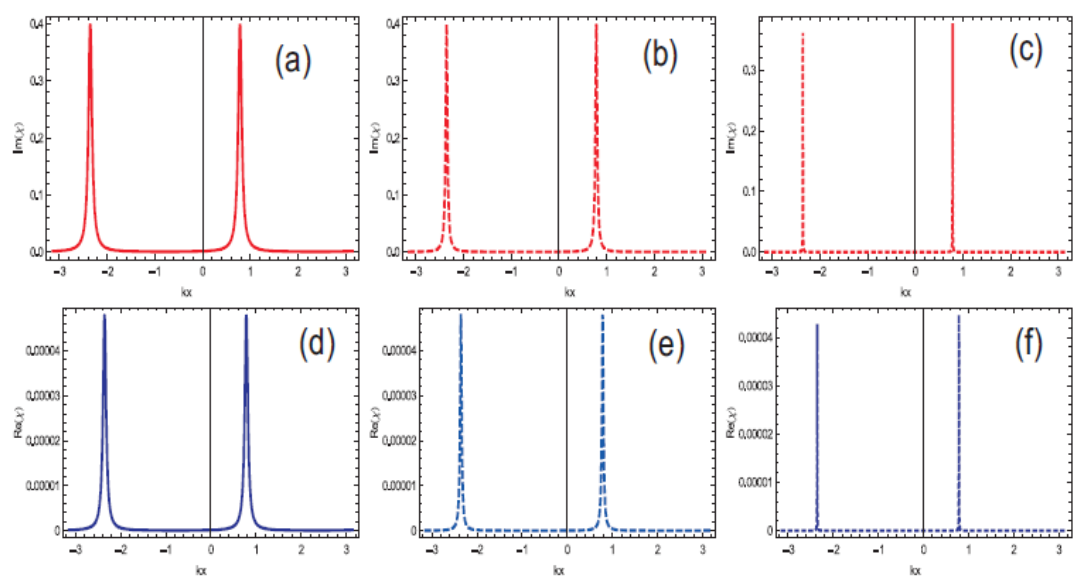
Figure 4. Localization of atom vs kx at the parameters γ = 1 GHz , | Ω 1,2,3 | = R = 50 γ [ a , d ] ,100 γ [ b , e ] ,1000 γ [ c , f ] ,